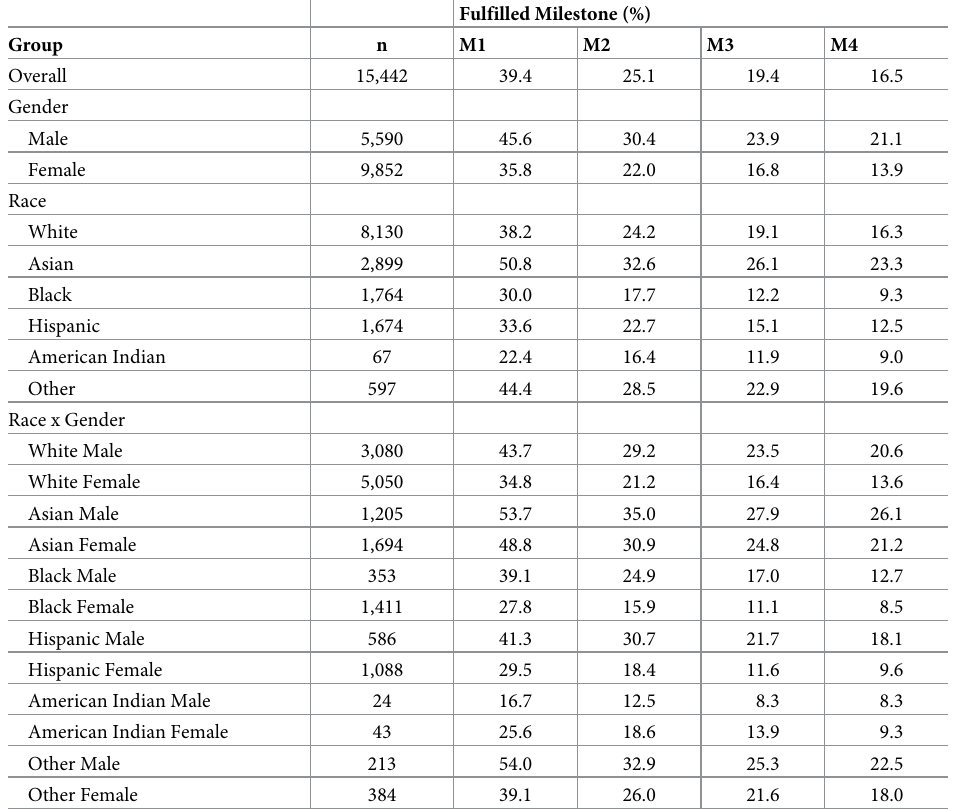
Table 1. Distribution of gender and race of the study population according to prerequisite fulfillers at each mile- stone: 2006–2009.